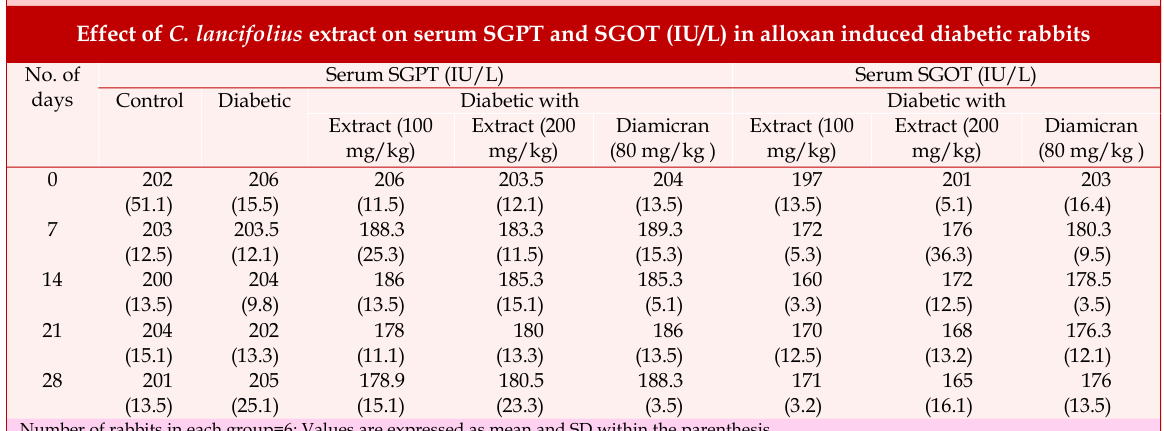
Effect of C. lancifolius extract on serum SGPT and SGOT (IU/L) in alloxan induced diabetic